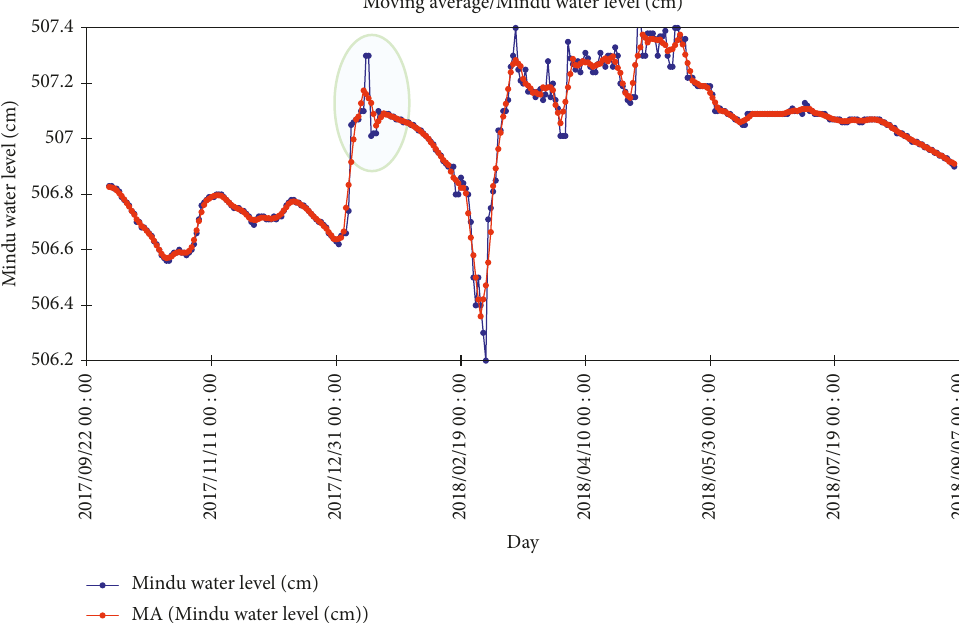
Figure 8: Moving average/water level (cm) for Mindu Dam for a period of October 2017 to August 2018 (data from Wami Ruvu basin office). A sharp increase (cycled) is attributed to the heavy rainfall (a case study being discussed) and thereafter dropping toward the end